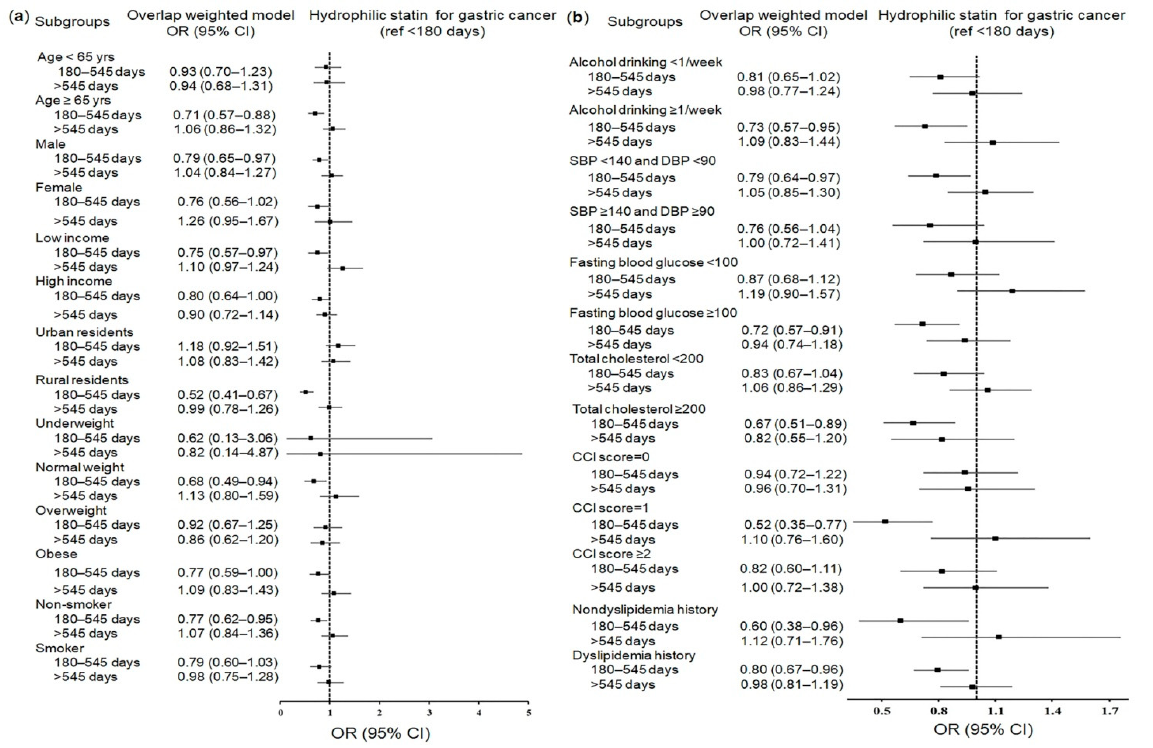
Figure 2. Forest plots for multivariable conditional logistic regression depicting the overlap weighted odds ratios (95% confidence intervals) of previous use duration of hydrophilic statins for incident gastric cancer according to comprehensive subgroup analyses, including age, sex, income, region of residence, obesity, and smoking ( a ), alcohol consumption, systolic blood pressure, diastolic blood pressure, fasting blood glucose, total cholesterol, CCI scores, and dyslipidemia history ( b ). The reference period is <180 days. Full results of the crude and adjusted overall weighted models are available in Supplementary Table S2 (hydrophilic statins).